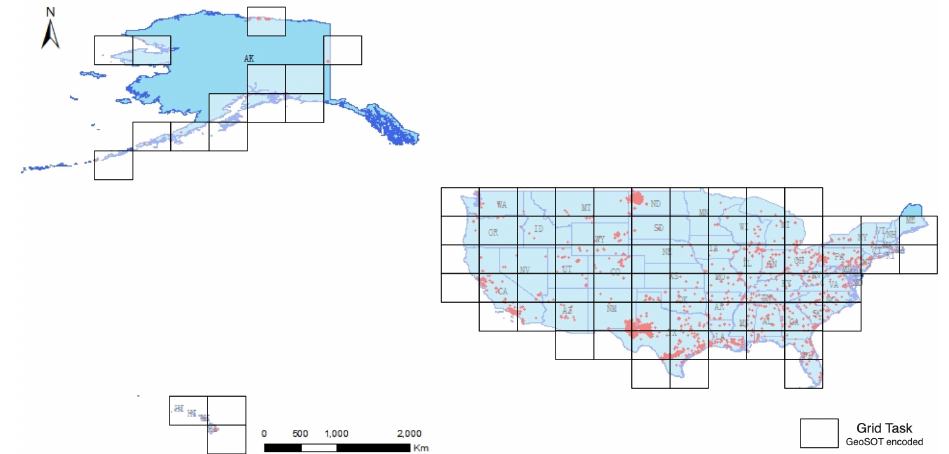
Figure 5. Grid tasks generated following a GeoSOT global